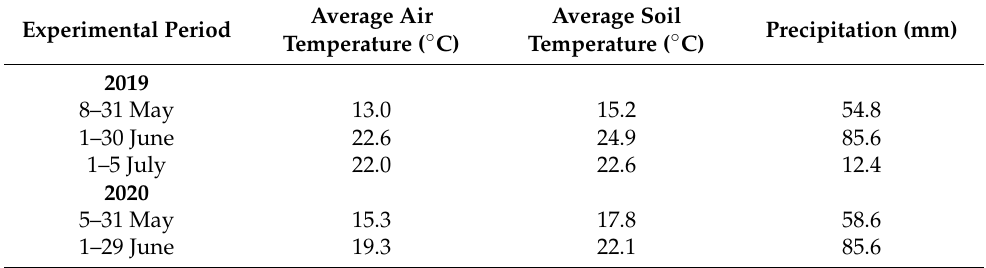
Table 1. Average air and soil temperature and precipitation for the Sasinovecki Lug field site, recorded during the two experimental periods. Air temperature and precipitation were provided by the university meteorological station located at the experimental field, while soil temperature was recorded with the temperature data logger (HOBO UA-001-08, Onset Computer Corporation, Bourne, MA, USA). Experimental